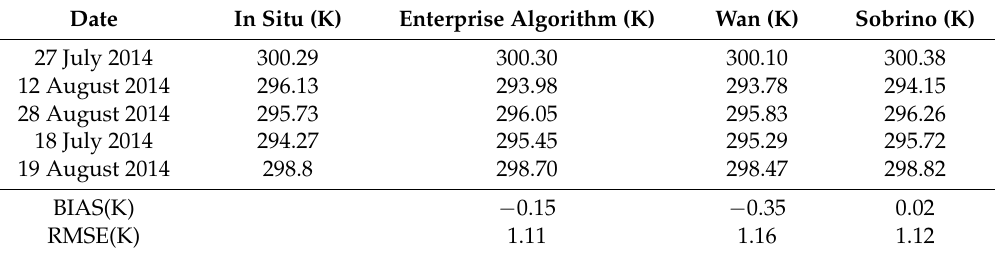
Figure 5. Scatterplots between ground-measured and Landsat LST estimated by three split-window algorithms. ( a ) the result of SURFRAD sites, ( b ) the result of HiWATER_A sites, ( c ) the result of HiWATER_B sites, and ( d ) the result of HiWATER_C sites. Sob, Wan, and Yu denote the split-window algorithm of Sobrino et al. [32], the general split-window algorithm, and the Enterprise algorithm. Table 5. Biases and RMSEs of retrieved LST at the BanGe site.